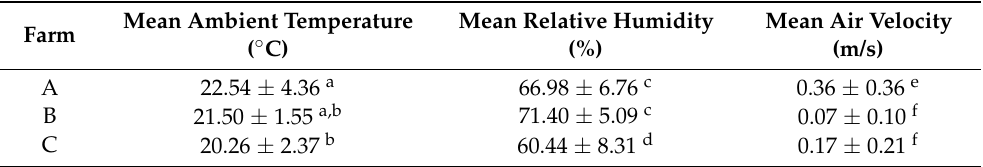
Table 4. Environmental conditions in the farrowing units of three different farms during the weaning period. Different superscripts differ statistically significantly ( p ≤ 0.05) between groups. Mean Ambient Farm